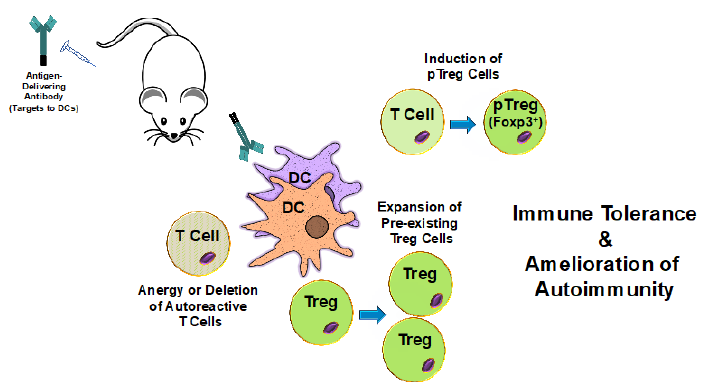
Figure 1. The delivery of self-antigens to dendritic cells induces tolerance and ameliorates autoimmunity. Antibodies specific for cell surface molecules expressed by dendritic cells (DCs) are fused with or conjugated to self-antigens. Upon in vivo administration, these antibodies target the antigens to DCs. DCs then internalize, process, and present the delivered antigens to T cells. Natural tolerogenic DCs (ntDCs) are good inducers of peripheral regulatory T cells (pTreg cells) and are often selected for antigen targeting purposes. This results in the induction of pTreg cells and, ultimately, in immune tolerance to the specific self-antigens and amelioration of autoimmune disease symptom severity. Additionally, antigens presented by some tolerance-inducing DCs may also promote the expansion of pre-existing regulatory T cells (Treg cells) as well as the anergy or deletion of autoreactive T cells.